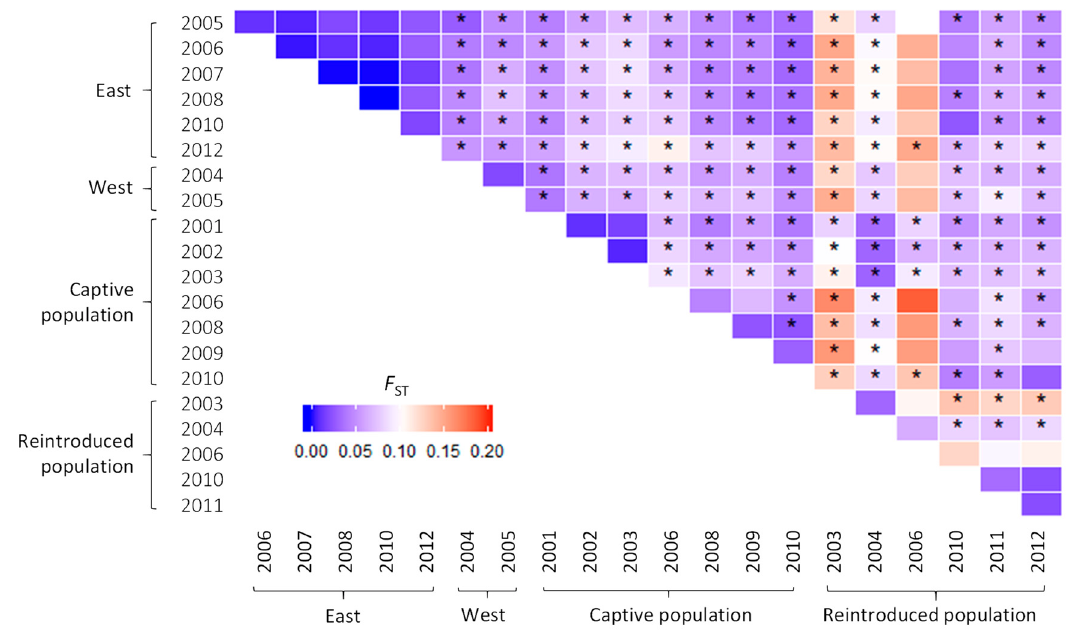
Figure 3. Pairwise F ST heatmap with F ST values ranging from 0 to 0.2 between source (east and west), captive and reintroduced populations of Parantechinus apicalis . F ST estimates significantly greater than zero ( p < 0.05) after correction for multiple comparisons are marked with asterisks.